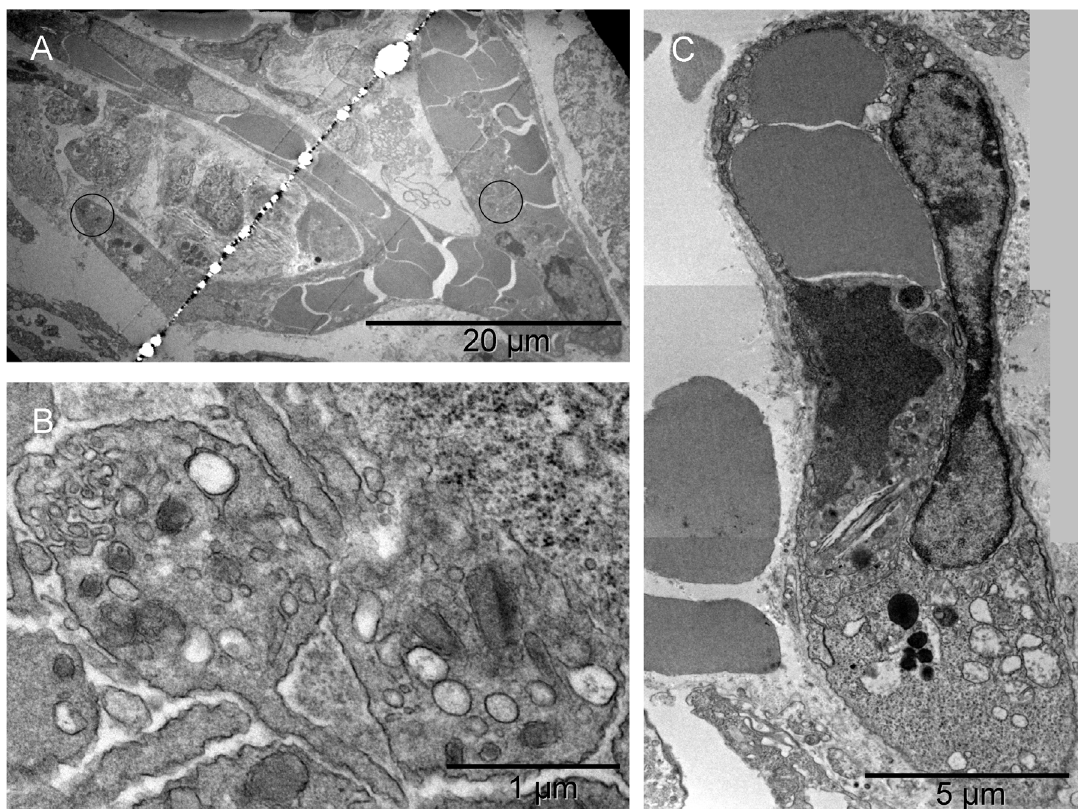
Figure 2. Primitive vascular pattern formed by megakaryocytes without endothelium. Primitive vascular pattern in the tumor-harboring solid tissue below the hyaline membrane consisted of megakaryocytes and platelets engaged in direct and tight contact with one another and with erythrosomes and erythroblasts. There were no ECM-filled spaces left between them nor was there an additional cellular layer covering those elements. The elongated branching structure in [ A ] appeared kept together by megakaryocytes and platelets (N.B. the line in the middle of the image is a scratch caused by an imperfection of the knife-edge during cutting the section). In the two circled regions of that structure, incomplete separation of platelets from megakaryocytes provided ultrastructural evidence for their identity and for an ongoing process of generating platelets at that location. One region was the bifurcation area at the base of the right almost vertical branch, enlarged in [ B ] and the other was the tip of the lower left branch (enlargement not shown). Evidently, megakaryocytes were capable of organizing erythrosomes into branching primitive vascular structure before ECs emerged to provide protective walls of a vessel. In a smaller elongated structure of similar nature, although without platelets in the section plane, one of the cells contained an Auer body [ C ], previously described in neutrophils from cases of leukemia and defined as azurophilic, large, elongated granules (Figure 64-10 in 57 ). The upper part of that cell contained two erythrosomes; whereas what remained of the nucleus had a different texture compared with that of the nucleus in the second cell of that complex. The prominent dark granules of the latter resembled those in the cell next to the megakaryocyte from the tip of the lower branching structure in [ A ]. If the irregularly shaped seemingly empty space next to those granules was a prototype of a lumen then both those cells could have potentially been